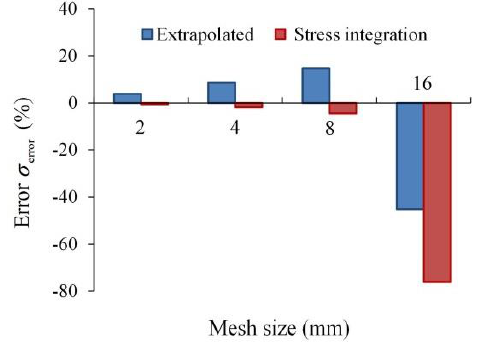
Figure 8. Error comparison of different approaches.